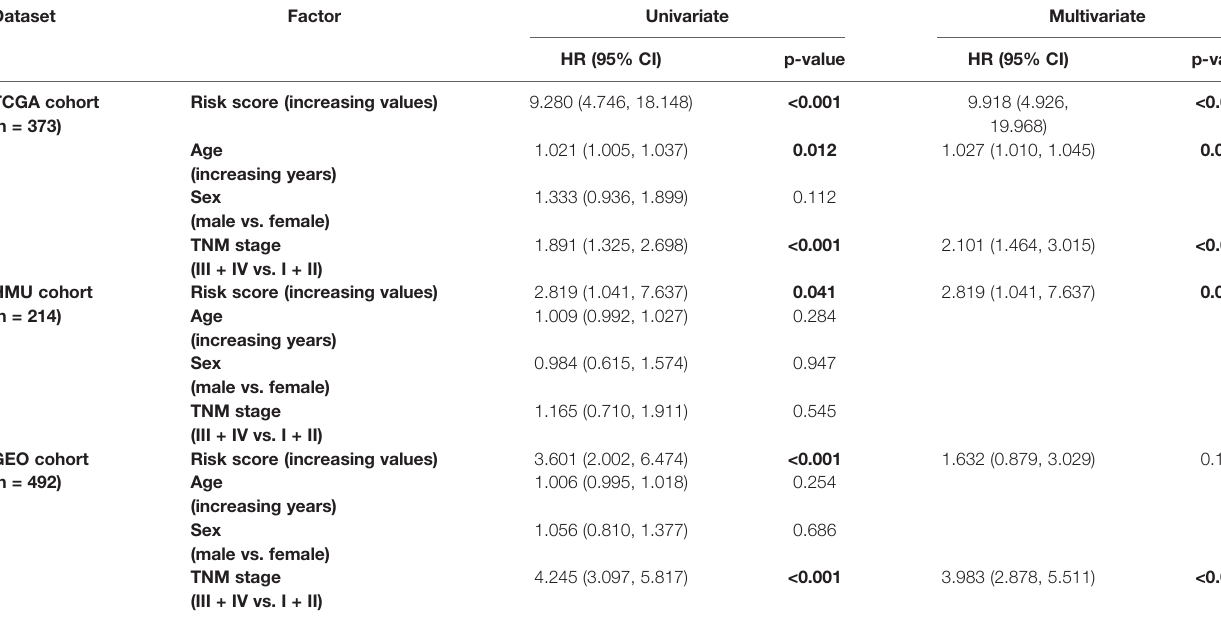
TABLE 2 | Univariate and multivariate Cox analyses of the RNA processing-related